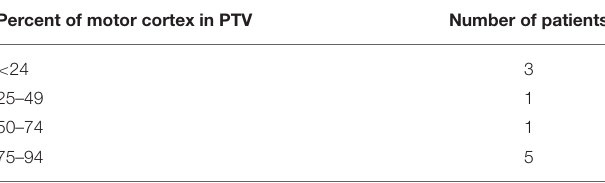
TABLE 2 | Overview of the overlap of motor cortex and PTV. Percent of motor cortex in